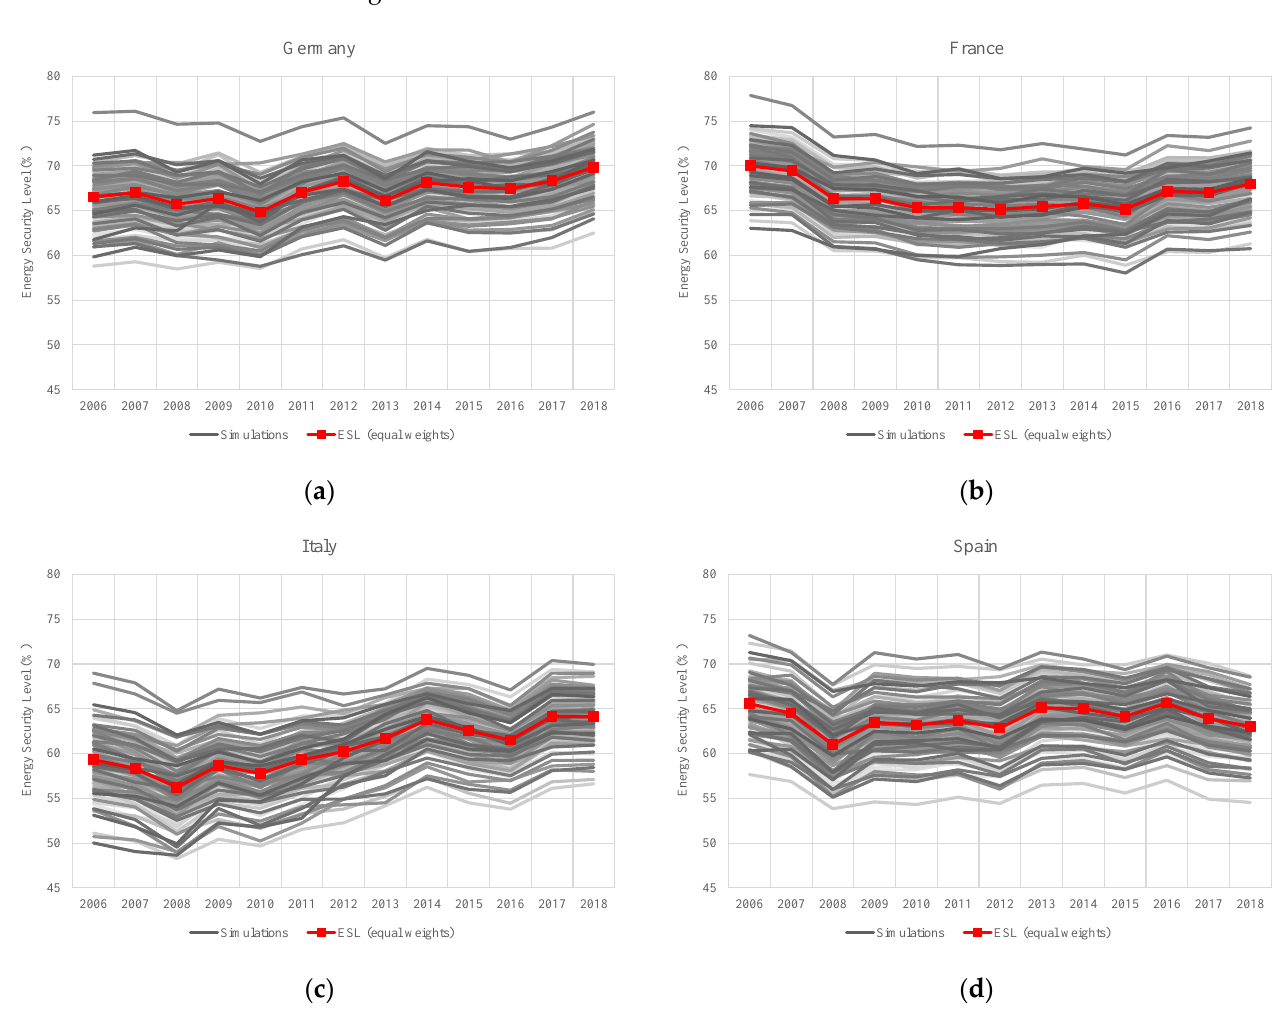
Figure 6. Simulated energy security level in the analyzed countries: ( a ) Germany, ( b ) France, ( c ) Italy, and ( d ) Spain. Source: own research.